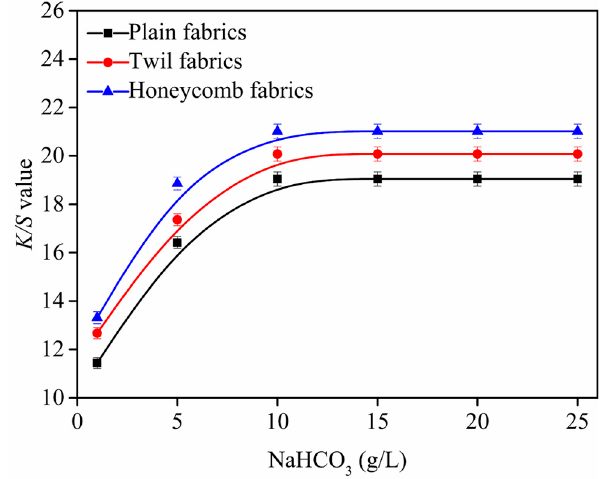
Figure 6. Effect of NaHCO 3 on K / S value, fabric was printed with cyan as a rectangle pattern of 80 × 150 mm and lines of 1 mm. All the pickup of fabrics were 70 ± 1% and steaming temperature was 102 ± 1 °C.